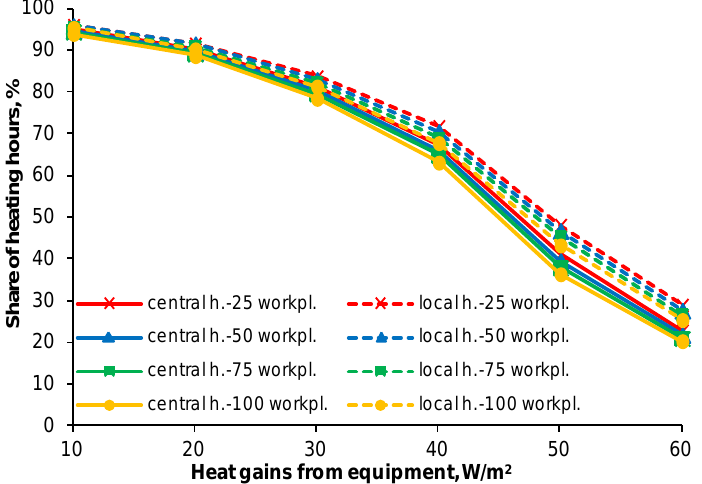
Figure 5. Percentage share of heating operative hours in the working period, heating from 16 to 20 °C with central and local systems for the cases investigated.